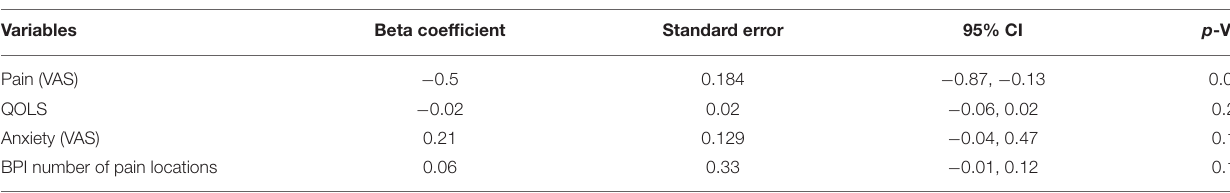
TABLE 5 | TSPS-tonic multivariate linear